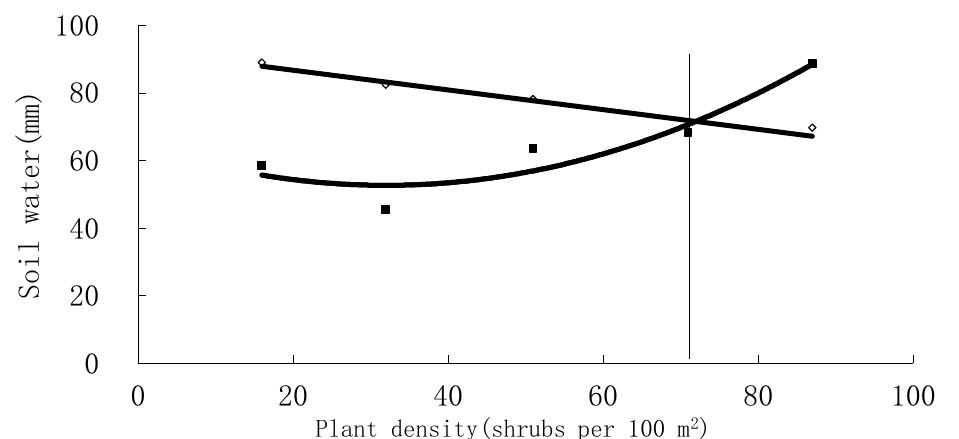
Figure 5. The changes in soil moisture supply (hollow circle) and soil moisture consumption (solid square) with plant density in the key period of the plant moisture relationship regulation of 18-year- old caragana shrubland in the semiarid hilly Loess region. The cross-point is the carrying capacity of soil water for vegetation.